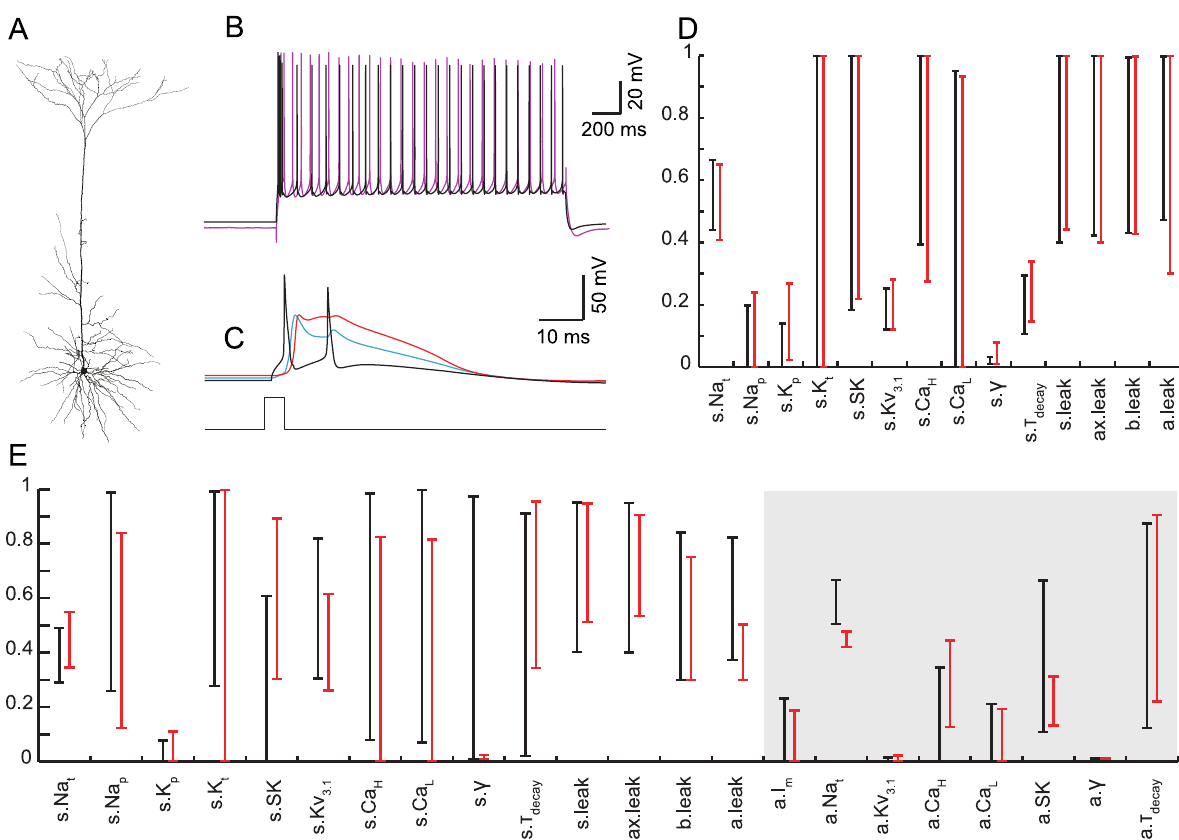
Figure 6. Model transfer to a similar morphology preserves perisomatic but not dendritic active properties. A. Reconstruction of a second L5b PC morphology of the same age as that of the cell in Figure 1A, with similar area and branching. B. Using the dually-constrained model shown in Figure 4 (and parameters shown in Table 3) with cell # 2 provided an acceptable perisomatic step current firing (experimental trace– magenta; simulation–black). C. Brief suprathreshold somatic stimulation of the model with cell # 2 generated BAC firing, in disagreement with the experimental results. D. Parameter ranges for acceptable models fitting perisomatic step current firing with cell # 1 (black, n=139) and cell # 2 (red, n=110) tightly overlapped. E. Parameter ranges for acceptable models fitting BAC firing with cell # 1 (black, n=899) and cell # 2 (red, n=948) generally overlapped, except for apical Na t density. Real values for the different ion conductances can be derived by referring to the upper limits given in Table